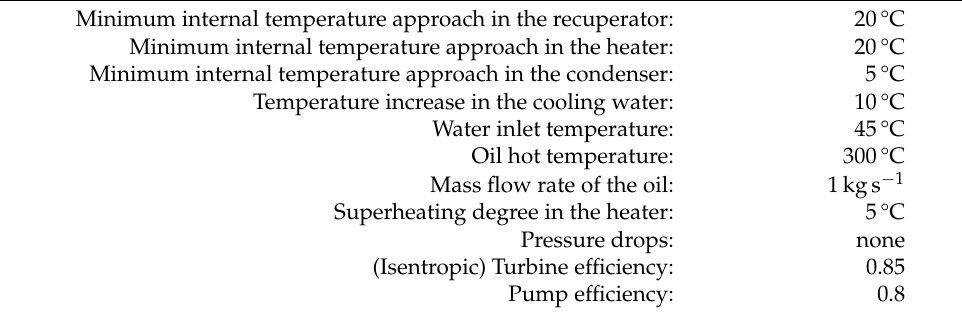
Table 4. Design parameters assumed for the thermodynamic cycle